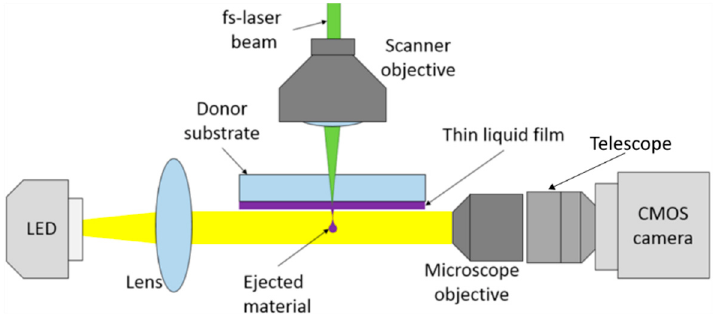
Figure 4. Schematic overview of the shadowgraph setup used for the visualization of the droplet